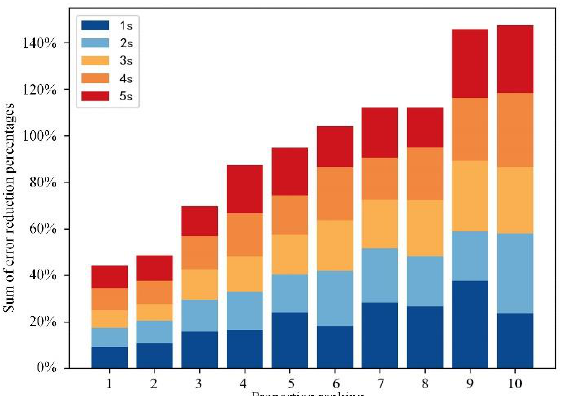
Figure 7. Percentage reduction in area error for each kind of time interval data processed afterward as compared to data processed without processing. The data of the same time interval are considered as a group, the x-axis coordinate represents the ranking of a field in its group, and the y-axis coordinate represents the sum of error reduction percentage of five fields (different time intervals) belonging to the same ranking.